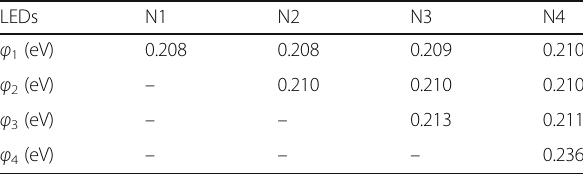
Table 3 Valence band barrier height for each PNP-AlGaN junction of LEDs N1, N2, N3, and